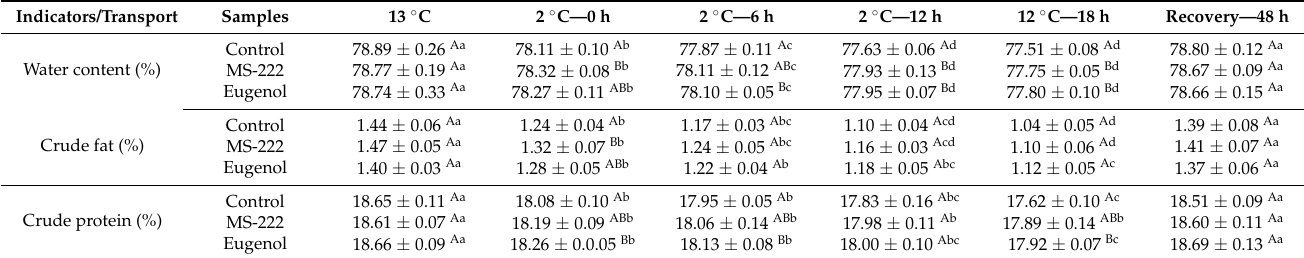
Table 1. The effect of low-temperature waterless transport stress on the chemical composition of turbot flesh.